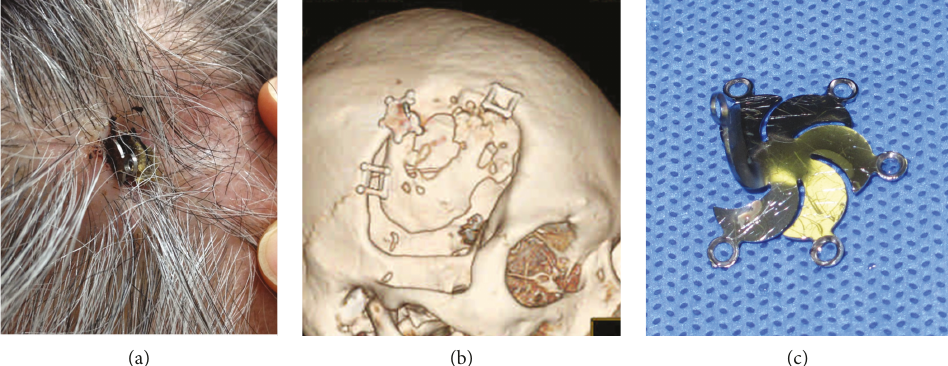
Figure 1: Change in shape of a pinwheel-shaped titanium mini plate. (a) A titanium plate that had been inserted during cranioplasty 16 years previously is protruding from the scalp through a circular defect. (b) Three-dimensional computed tomography (3D-CT) scan image showing that part of the titanium plate has been bent upwards. (c) After surgical removal, the bend in the plate is clearly visible.